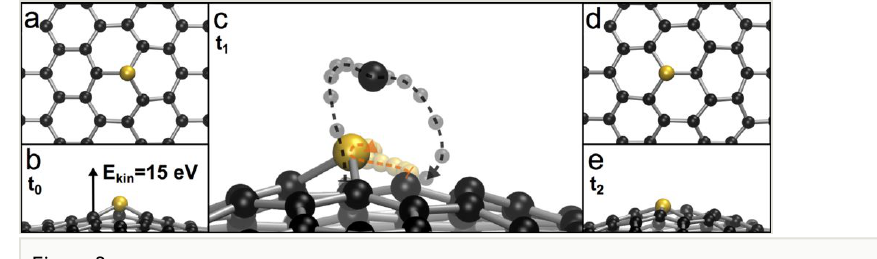
Figure 2. Snapshots of a simulated 150 fs trajectory of a C atom that has received 15 eV of kinetic energy from an energetic electron, based on a density functional theory molecular dynamics (Susi et al. 2014). After a complex out-of-plane movement, the silicon-carbon bond is inverted.